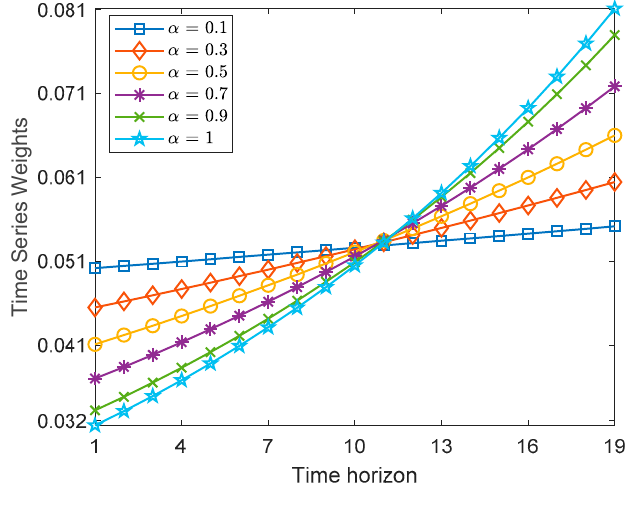
Figure 8. Time series weights.